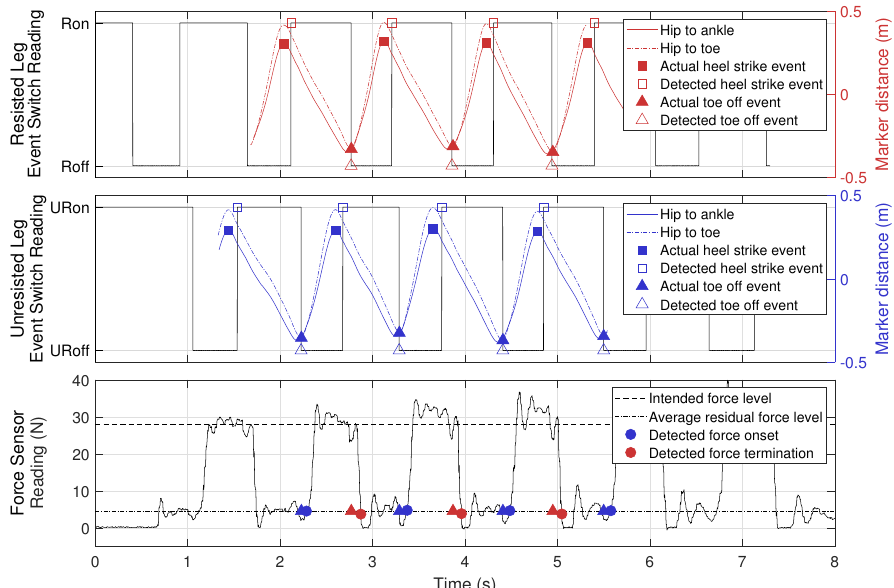
Figure 8. Data from an example trial in the verification test.